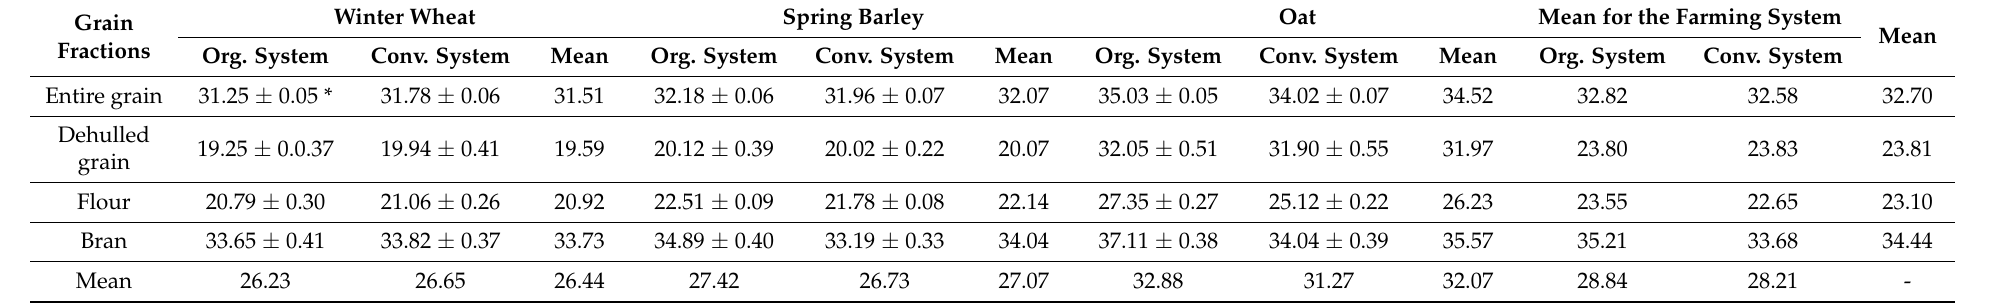
Table 3. Effect of cereal grain milling on DPPH • free radical quenching capacity (% RSA; RSA = AG, 516 nm (start)—AB, 516 nm (6 min))—2017–2019 average.